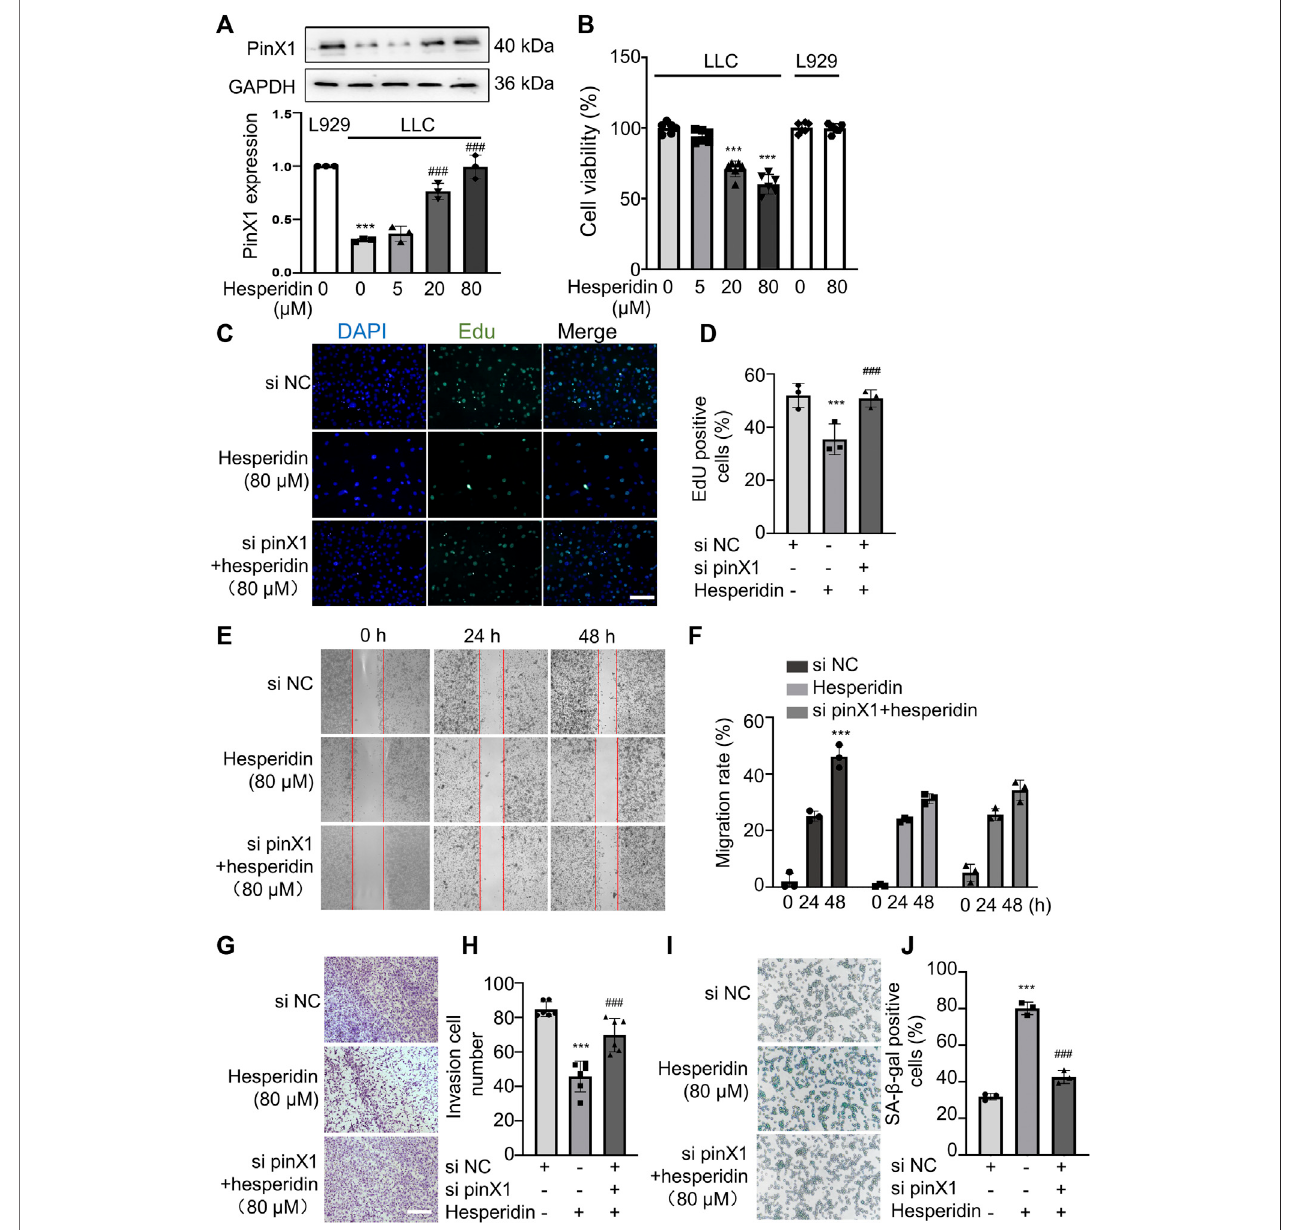
FIGURE4| HesperidininhibitedLLC cellproliferation, invasion,and migrationand promotedcellsenescence via pinX1. (A) Hesperidin increasedthepinX1protein expression. n =3;dataareshownasmean±SD.*** p < 0.001comparedwithL929and### p < 0.001comparedwithLLCcontrol. (B) Hesperidininhibitedcellviabilityin LLC cells but not L929 cells. n = 5; data are shown as mean ± SD. *** p < 0.001 compared with the control group. (C) and (D) EdU staining. n = 3; data are shown as mean ±SD. *** p < 0.001 compared with the siNC group and ### p < 0.001 compared with the hesperidin group. (E) and (F) Wound healing assay. n = 3; data are shown as mean ± SD. *** p < 0.001 compared with the si NC group. (G) and (H) Transwell invasion assay. n = 6; data are shown as mean ± SD. *** p < 0.001 compared with the si NC group and ### p < 0.001 compared with the hesperidin group. (I) and (J) SA- β -gal staining. n = 3; data are shown as mean ± SD. *** p < 0.001 compared with the si NC group and ### p < 0.001 compared with the hesperidin group.